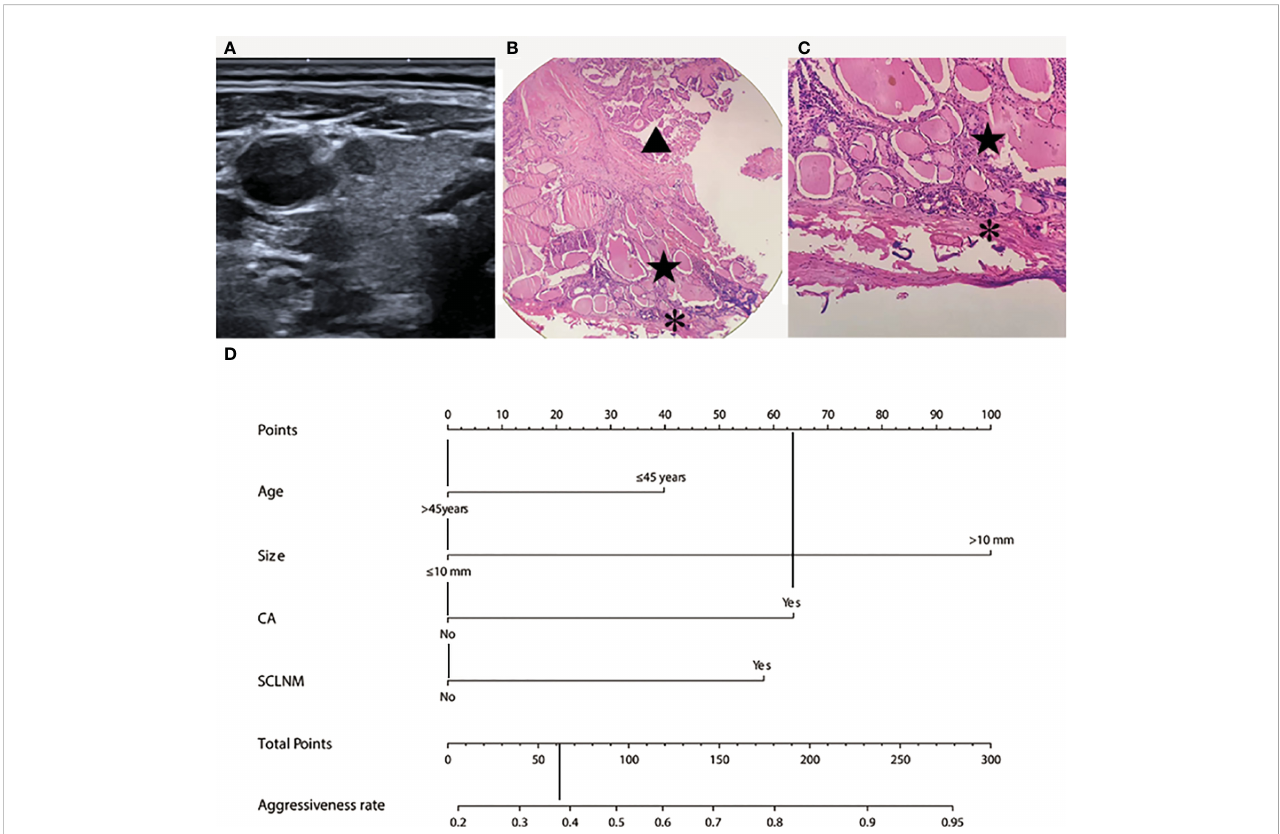
FIGURE 4 Example of nomogram usage for predicting non-aggressive papillary thyroid carcinoma. In patient 1 (male, 47 years old), preoperative fi ne needle aspiration cytology con fi rmed papillary thyroid carcinoma in the right middle part of the thyroid. (A) Conventional ultrasound showed the size was 4.3 mm, with capsule abutment (CA) and no suspected cervical lymph node metastasis (SCLNM). Pathological assessment revealed no capsular invasion. (B) and (C) showed normal thyroid tissue (pentagram) between papillary thyroid carcinoma (triangle) and the capsular (star) at different magni fi cations (HE staining, 100 ×and 200×, respectively). On the nomogram (D) , this patient showed a total score of approximately 62 and the predicted risk of aggressiveness was less than